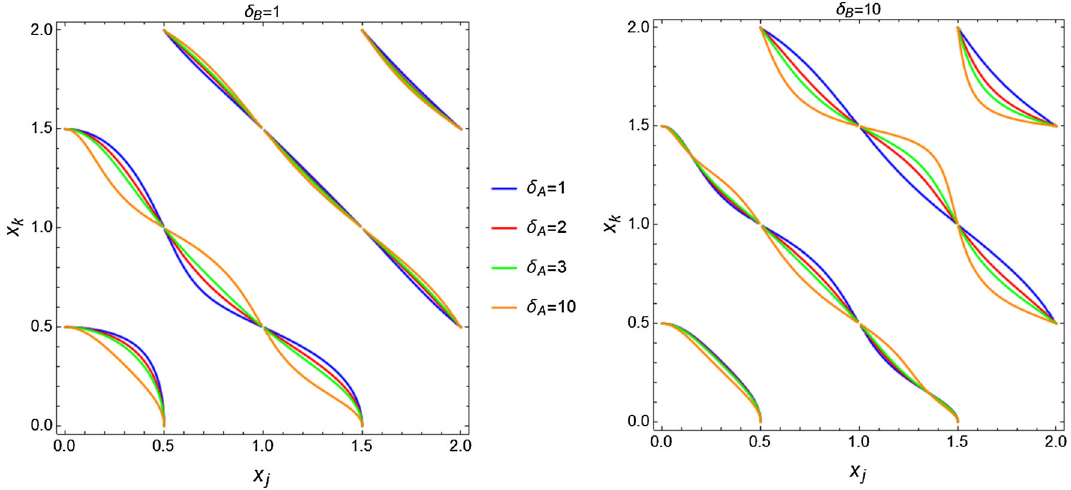
Fig. 3 Solutions of the transcendental Eq. (30) for different values of δ A and two values of δ B , for the thin-brane